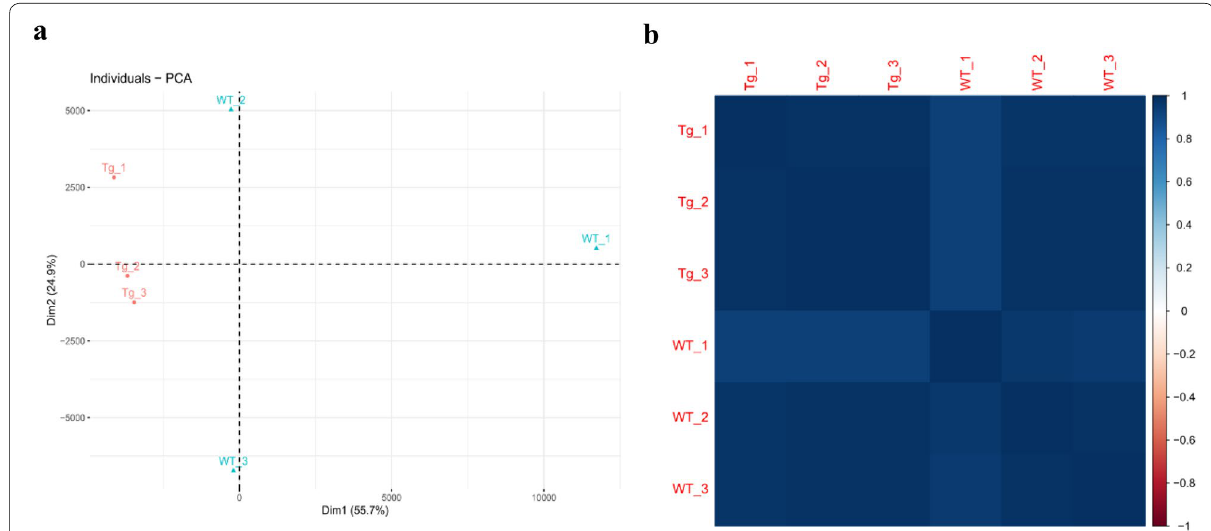
Fig. 2 Sample correlation analysis using PCA and Pearson correlation. a PCA analysis of the gene expression level for peripheral blood mononuclear cells. b Pearson correlation analysis of the gene expression level for peripheral blood mononuclear